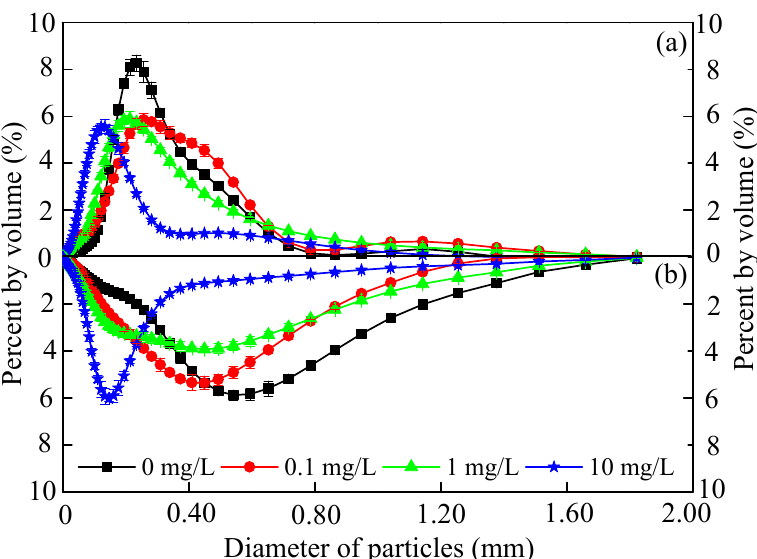
Figure 1. The size distribution of sludge in one cycle after 1 day ( a ) and 10 weeks ( b ) of exposure to 0 (black), 0.1 (red), 1 (green), and 10 (blue) mg / L CeO 2 nanoparticles (NPs), respectively. Error bars represent standard deviations of triplicate measurement.